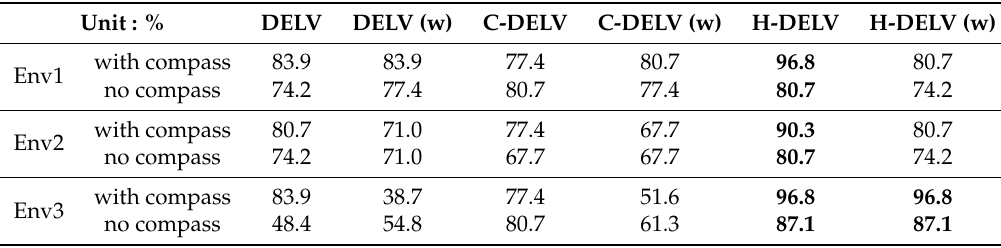
Table 1. Percentage of test points with small angular errors (errors are in the range of [ − 45 ◦ , 45 ◦ ] and (w) indicates the method with weighted landmark